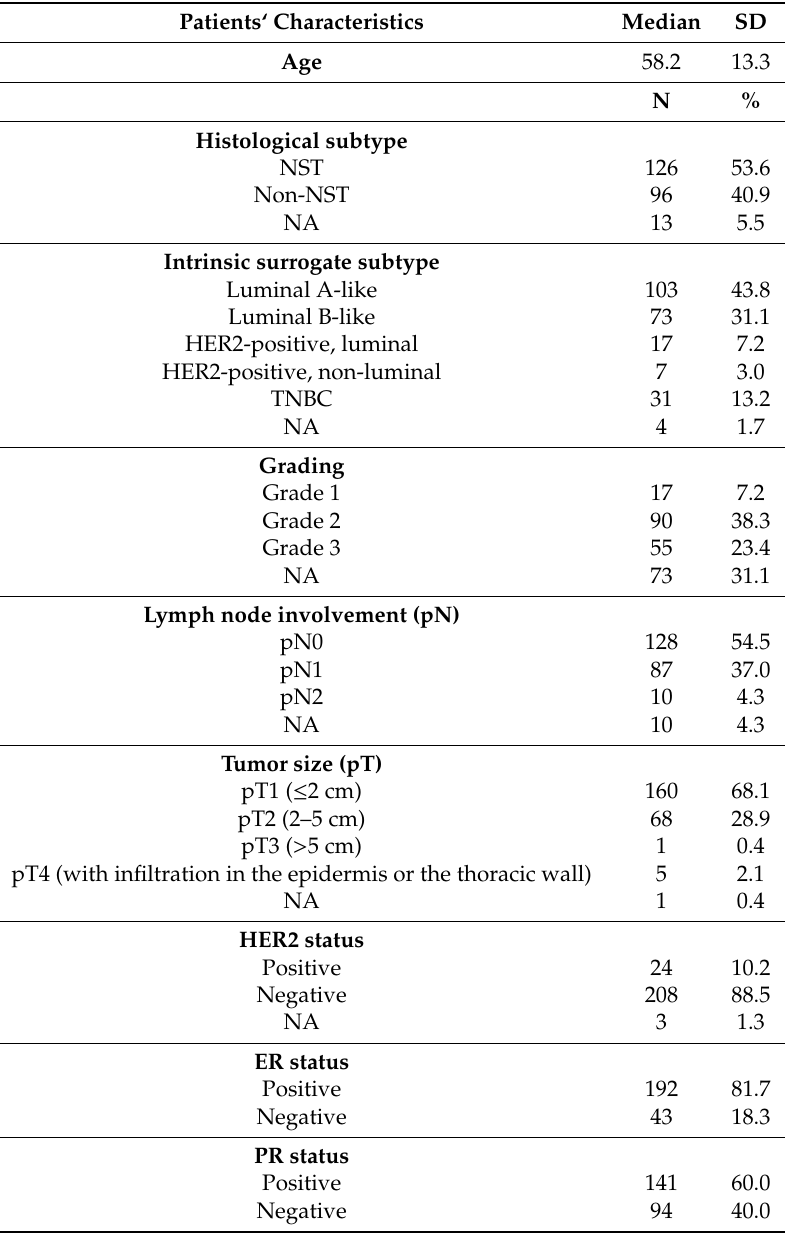
Table 6. Patients’